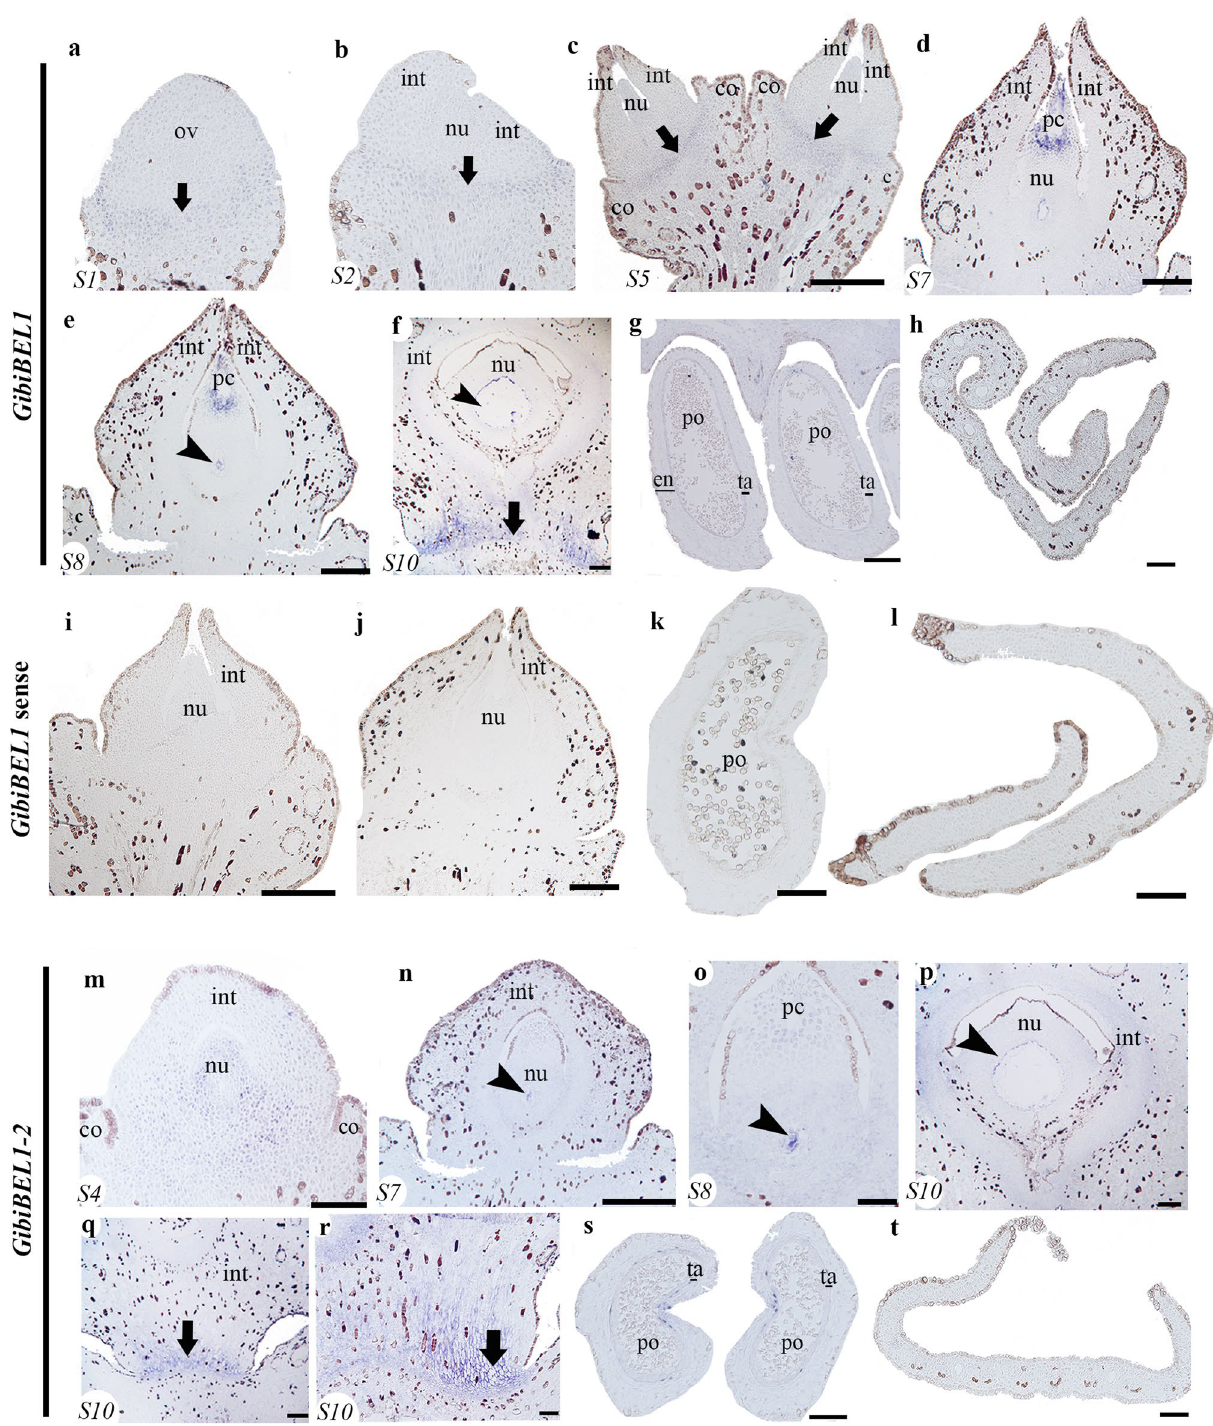
Figure 2. Expression of BEL1 homologues using in situ hybridization. (a–h) Expression patterns of GibiBEL1 . (a) Ovule in stage 1 (S1). (b) Ovule in stage 2 (S2). (c) Ovule in stage 5 (S5). (d) Ovule in stage 7 (S7). (e) Ovule in stage 8 (S8). (f) Stage 10 (S10), close-up of the abscission zone. (g) Pollen cone. (h) Cross section of the leaf. (i–l) GibiBEL1 sense probe as control. (m–t) Expression patterns of GibiBEL1 -2. (m) Ovule in stage 4 (S4). (n) Ovule in stage 7 (S7). ( o) Close-up of the nucellus of an ovule in stage 8 (S8). (p) Close-up of the nucellus of an ovule at stage 10 (S10). (q,r) Abscission zone of the ovule in stage 10 (S10). (s) Microsporangia. (t) Cross section of a leaf. The corresponding ovule stage (S) is shown at the bottom left of each picture. Black arrows pointing to the abscission zone; black arrowheads pointing to the megaspore mother cell; co collar, en endothelium, int integument, nu nucellus, po pollen, ta tapetum. Scales: 50 μm ( c,d,i,j,l,r,t ); 75 μm ( e,k,n,o ); 100 μm ( f–h,p–s